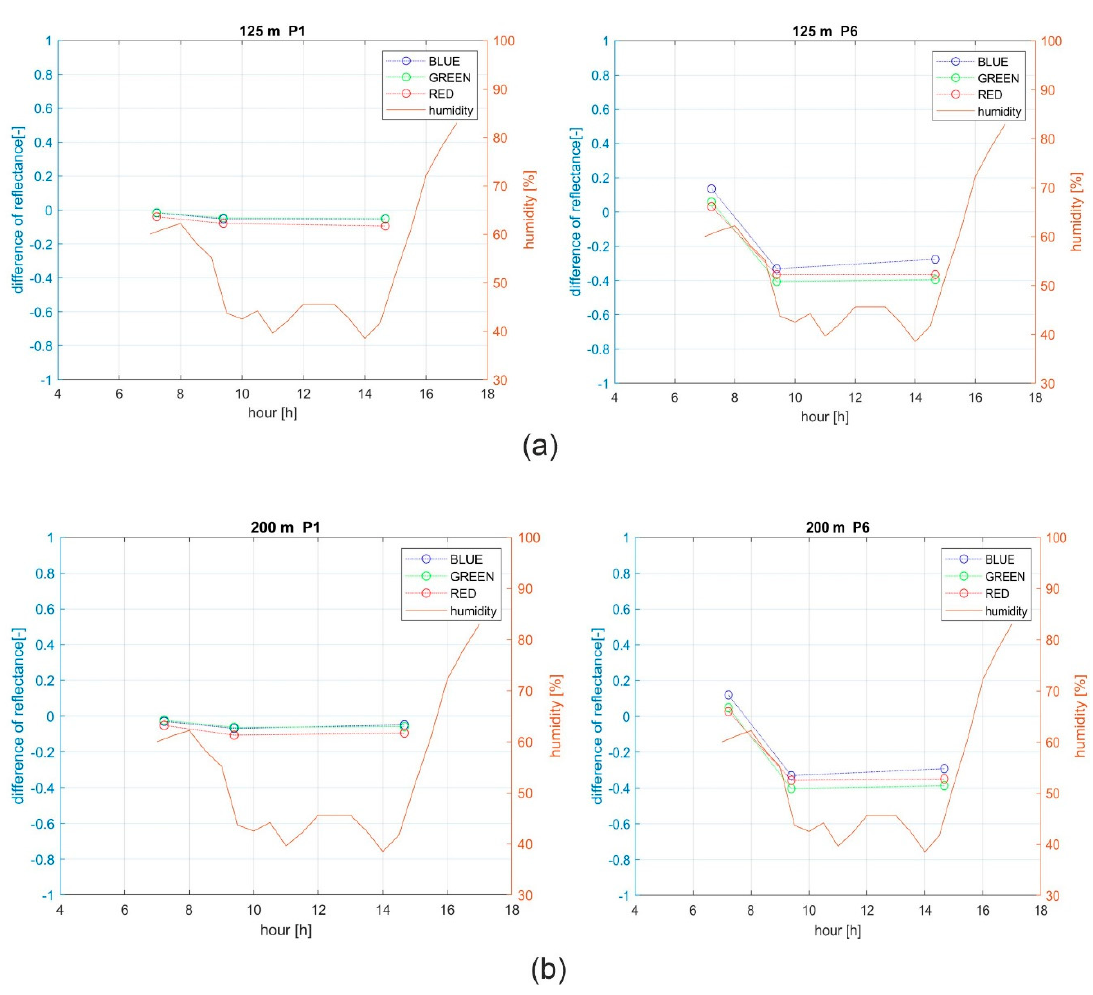
Figure 16. Air humidity and residuals from the theoretical value of reflectance for 2 and 95% tests for Figure16. Airhumidityandresidualsfromthetheoreticalvalueofreflectancefor2and95%testsfordata data obtained at ( a ) 125 m and ( b ) 200 m in good weather conditions (Ko ś cielisko area, September 26, obtained at ( a ) 125 m and ( b ) 200 m in good weather conditions (Ko´scielisko area, September 26, 2018).